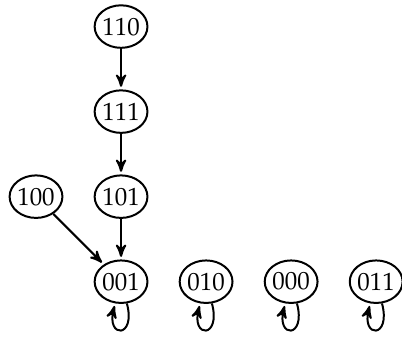
Figure 4. Phase portrait of the system F ( x 1 , x 2 , x 3 ) = ( x 1 ∧ x 2 , x 2 ∧ ( x (cid:48)